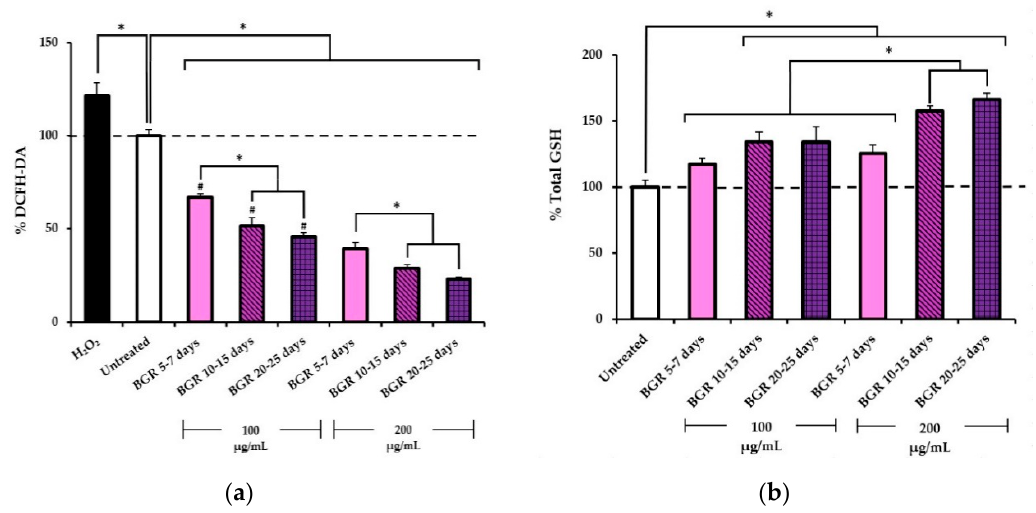
Figure 2. ( a ) Flow cytometry analysis of intracellular ROS (H 2 O 2 ) by DCFH-DA assay. H 2 O 2 (0.1 µ g / mL) was used as a positive control. Data are expressed as mean ± SD of four replicates. ( b ) Total endogenous glutathione (GSH) level in the Jurkat cells treated with BGR. Data are expressed as mean ± SD of triplicates. (*) Value is significantly different ( p < 0.05). (#) p < 0.05 when compared the same extract at different concentrations.